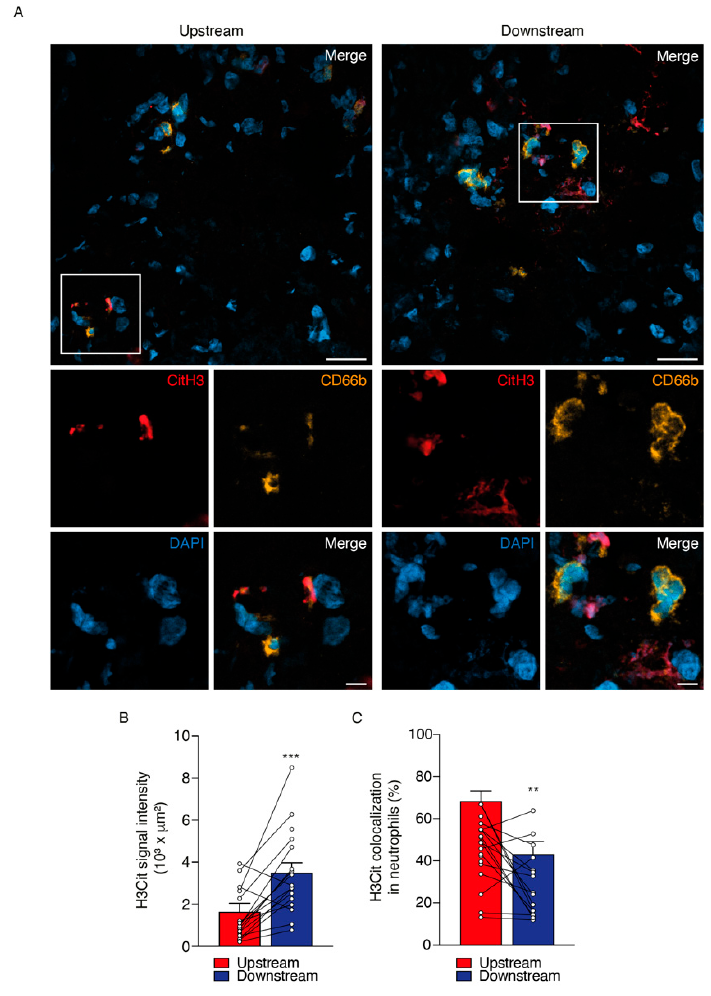
Figure 3. Citrullinated histone-3 (H3Cit) signal intensity and cellular localization on upstream versus downstream plaque regions of human carotid artery. ( A ) Representative microphotographs of immunofluorescence signal for H3Cit (red panels) and its colocalization with neutrophil (CD66b, yellow) and nuclei (DAPI) on upstream (left panels) and downstream (right panels) plaque regions of human carotid artery. Respective quantification representing bar graph average of H3Cit pixel intensity ( B ) and % of colocalization with neutrophil cells ( C ) upstream (red bars) and downstream (blue bars) to the blood flow of plaque regions. Analysis of immunofluorescence images was performed in Imaris software and expressed as mean ± SEM. Scale bar for A: 20 µ m (top panels) and white frames in ( A ) represent area selection for larger magnification images of 5 µ m (bottom panels). n = 16 patients for each atherosclerotic region. *** p < 0.001 and ** p < 0.01 Wilcoxon Matched Pairs test.